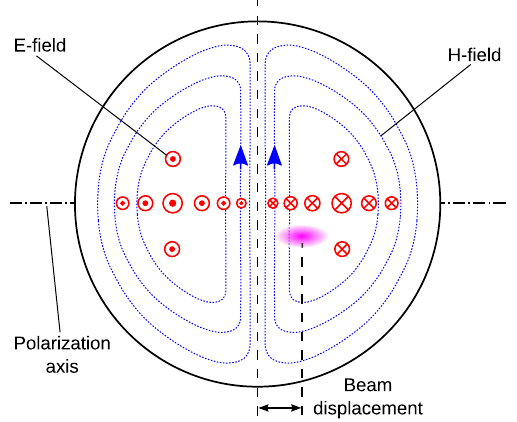
FIG. 1. A simplified, schematic view of the TM mode field distribution, as used in beam position